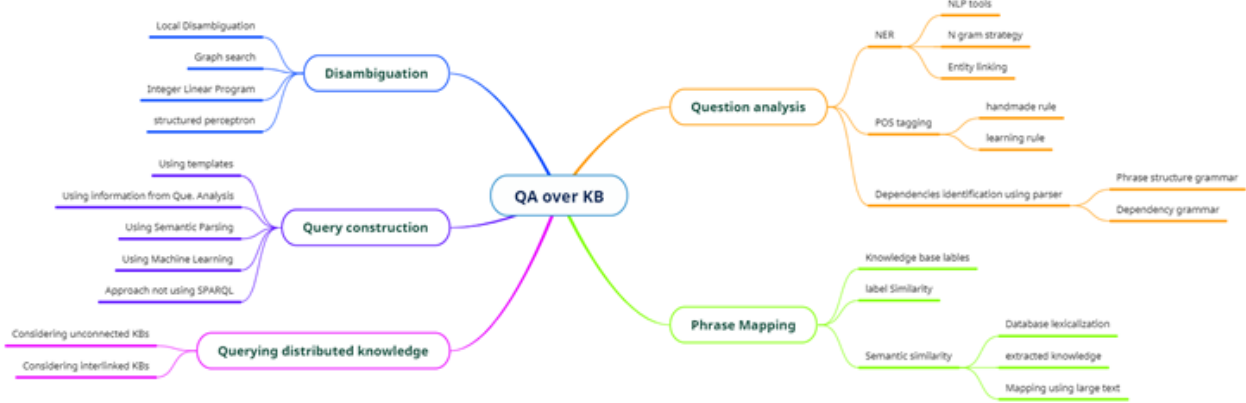
Figure 17. Important Task in